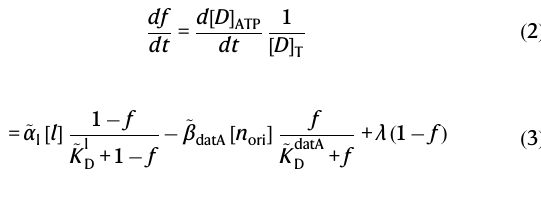
doubling time τ d =2h). The average active fraction over one cell cycle 〈 f 〉 is indi- catedinredinthethirdpanel.Replicationisinitiatedatacriticalinitiatorfraction f * (reddashedline)andthesystemgivesrisetoaconstantinitiationvolumeperorigin v * overtime (greendashed line). c The amplitude Δ f of the oscillationsinthe active fraction f as a function of the growth rate for different magnitudes of the (de) activationrates( α l =4.6× β datA ).Theamplitudeoftheoscillations Δ f becomessmall forbiologicallyrealisticvaluesofthe(de)activationratesintheLDmodel(redsolid curve),butnotintheLDDRmodel(reddashedcurve).(SeeSupplementaryTable2 for all parameters and Supplementary Fig. 9 for time traces of LDDR